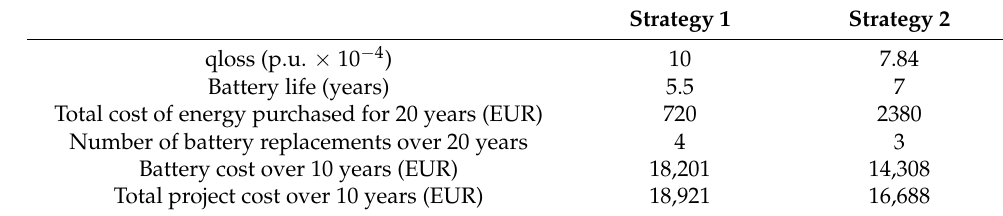
Figure 10. Capacity loss ( a ) and SOC of the battery ( b ) for strategies 1 and 2. Table 2. Total cost of strategies 1 and 2 for a 20-year microgrid project with 𝑆𝑂𝐶 𝑚𝑎𝑥 = 100 and 𝑇 = 25 °C.